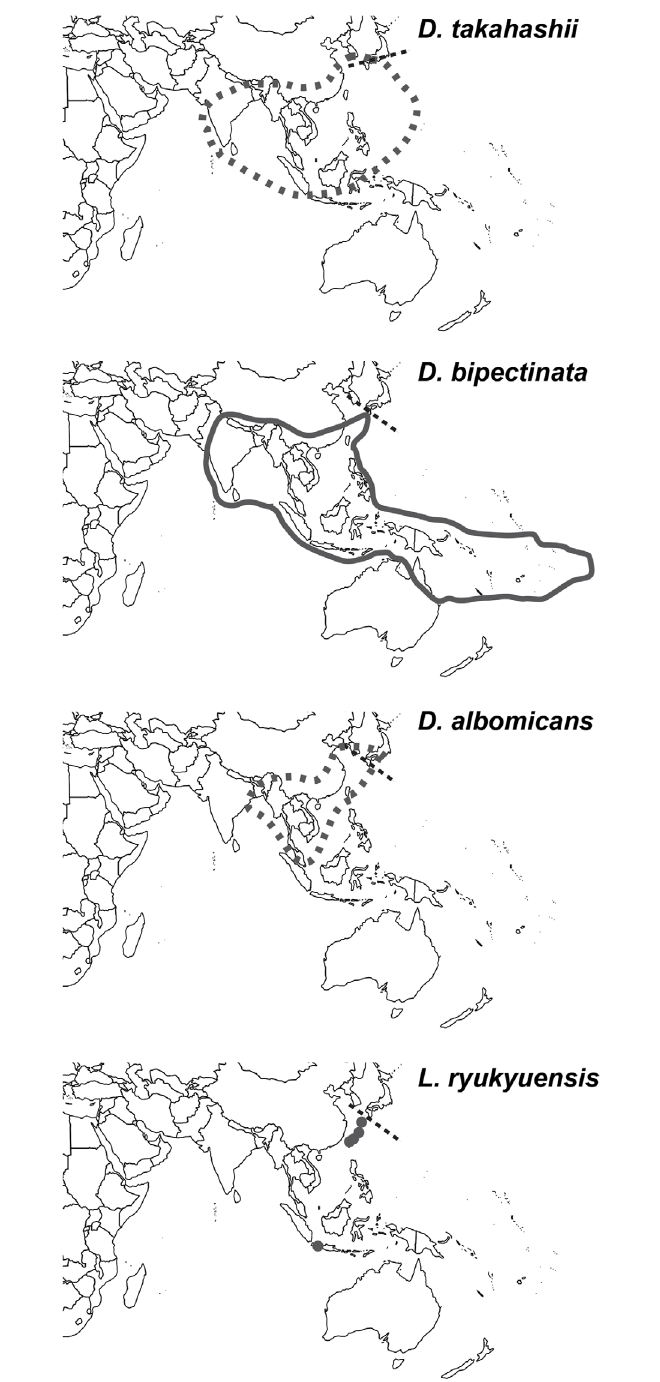
Fig 1. Estimates of distribution for the four study species. Distribution maps were based on available previous studies [23, 25 – 28]. Further studies are required to establish the exact distribution of L . ryukyuensis , and confirm distributions of D . takahashii and D . albomicans in regions where disambiguation from sister- species has proved challenging. Dotted lines indicate the northernmost border of the natural distribution for these four